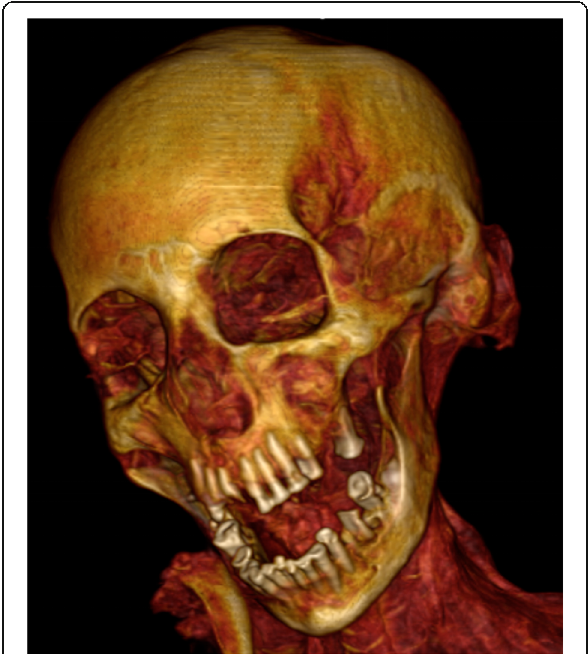
Fig. 3 Three-dimensional CT image of the head of mummy “ Unknown-Woman-A. ” The head is tilted to the right, and the opened mouth shows extensive teeth attrition, periodontitis, and caries